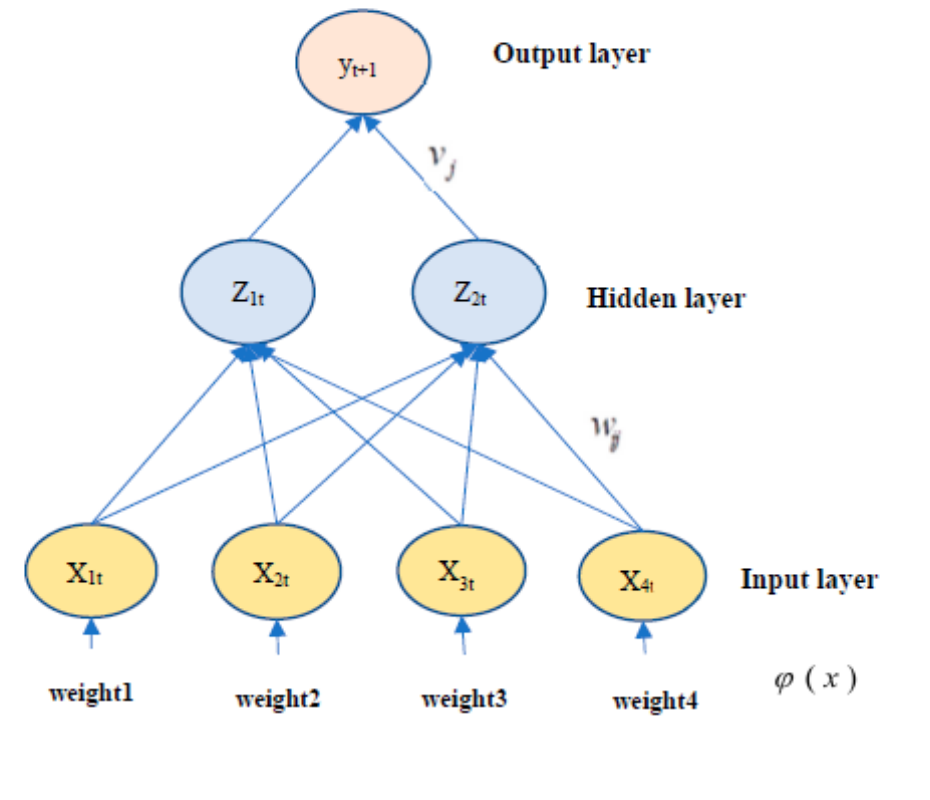
Figure 1. Topology of the WT-FNN neural network.